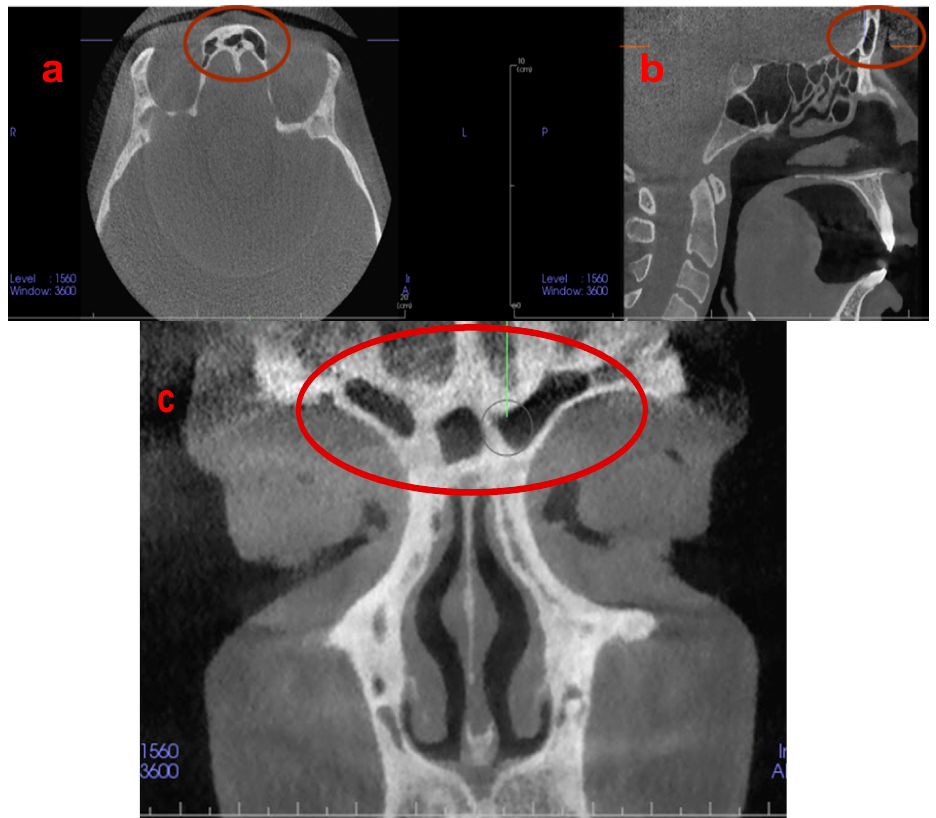
Figure 1. ( a ) Axial, ( b ) sagittal, and ( c ) coronal CBCT images demonstrating the unique and individ- ualised architecture of the frontal sinuses.